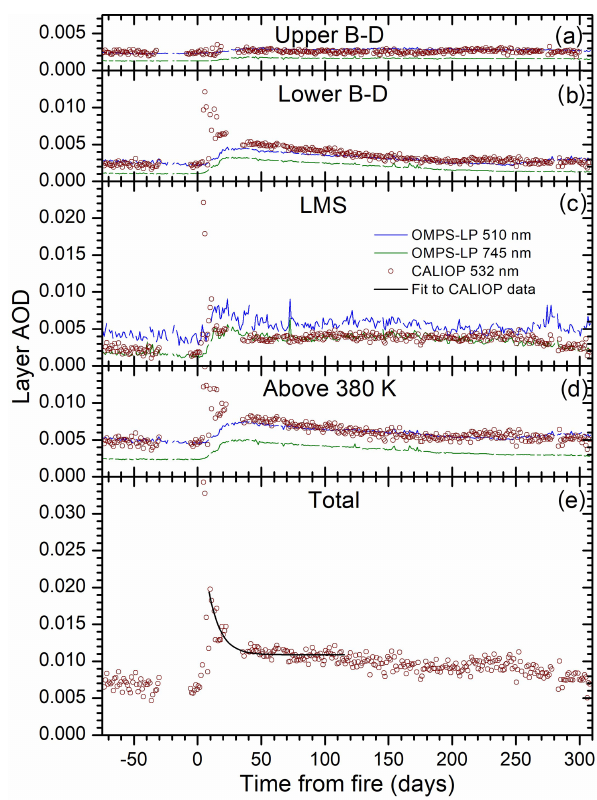
Figure 5. AOD evolution of the stratospheric AOD (daily average) from 75d before to 310d after the 2017 western North American fires. Comparisons of AOD from CALIOP (532nm) with OMPS- LP (510 and 745nm) with cloud filtering and flags activated for (a) the upper Brewer–Dobson branch (470K isentrope – 35km), (b) the lower Brewer–Dobson branch (380–470K), (c) the LMS (tropopause – 380K), and (d) from 380K to 35km ( sum of lay- ers in a , b , and e) the stratosphere of CALIOP from the tropopause to 35km ( sum of layers in a , b , and c) . The full black line is an exponential fit ( R 2 = 0 . 79, P < 10 − 10 ) to the AOD over days 10– 115 after the fire. The total stratospheric AOD half-life of the fit is 6 . 5 ± 0 .